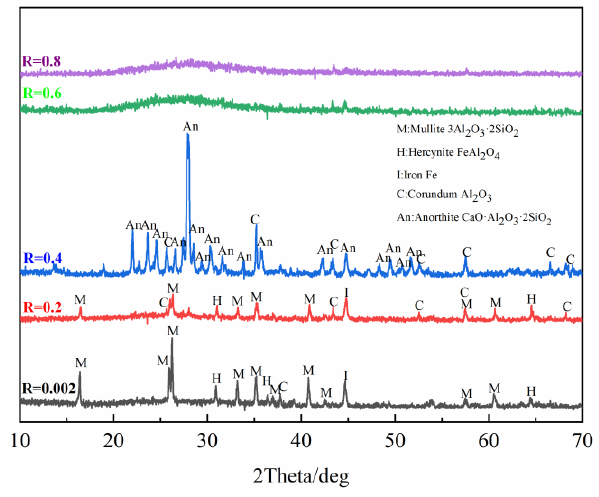
Figure 13. XRD patterns of the slag obtained from smelting separation at different basicity levels. Table 7. The content of main compositions in the slag of Figure 13 (wt. %).